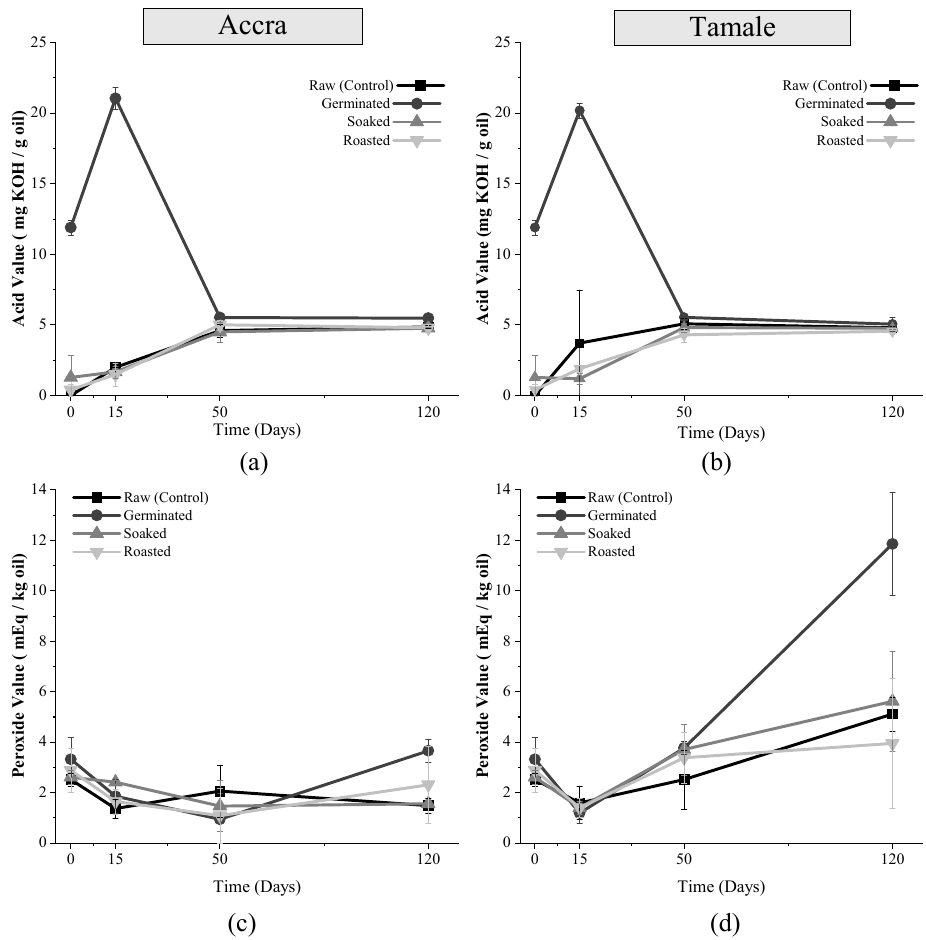
Figure 2. Changes in oxidative stability markers of FFSF during 120 days of storage in different locations. ( a ) AV change in samples stored in Accra; ( b ) AV change in samples stored in Tamale; ( c ) PV change in samples stored in Accra; ( d ) PV change in samples stored in Tamale.